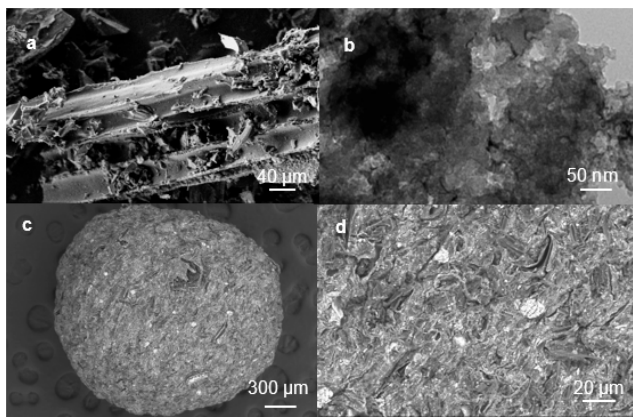
Figure 1. Commercial activated carbon SEM ( a ) and TEM ( b ) micrograph. SEM image of the MAAC bead surface ( c ) and internal structure ( d